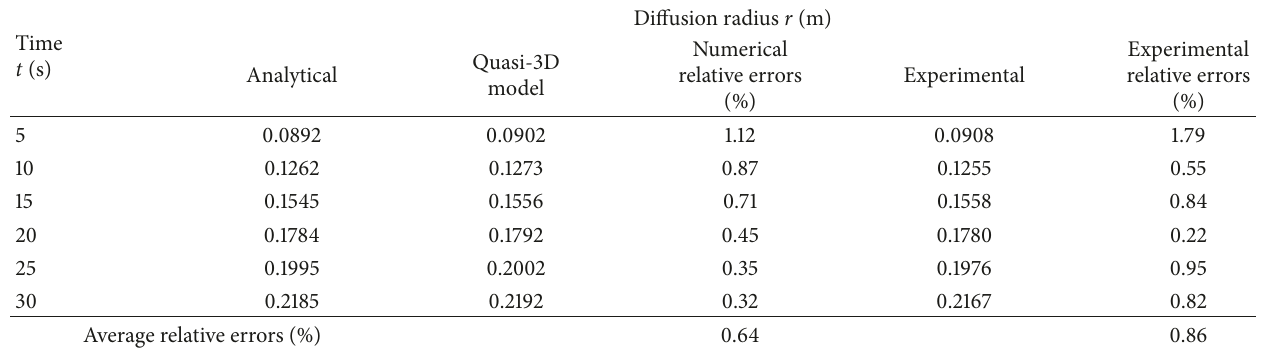
Table 10: Diffusion radius at different times for the three methods.